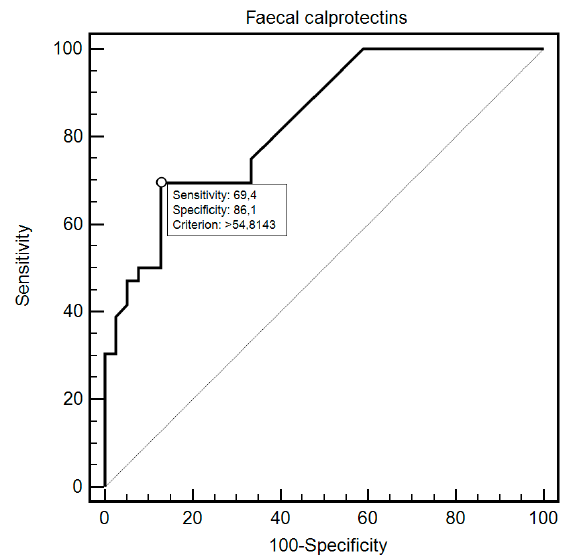
Figure 1. Receiver operating characteristic (ROC) curve illustrating the diagnostic utility of fecal calprotectin in SSc detection.